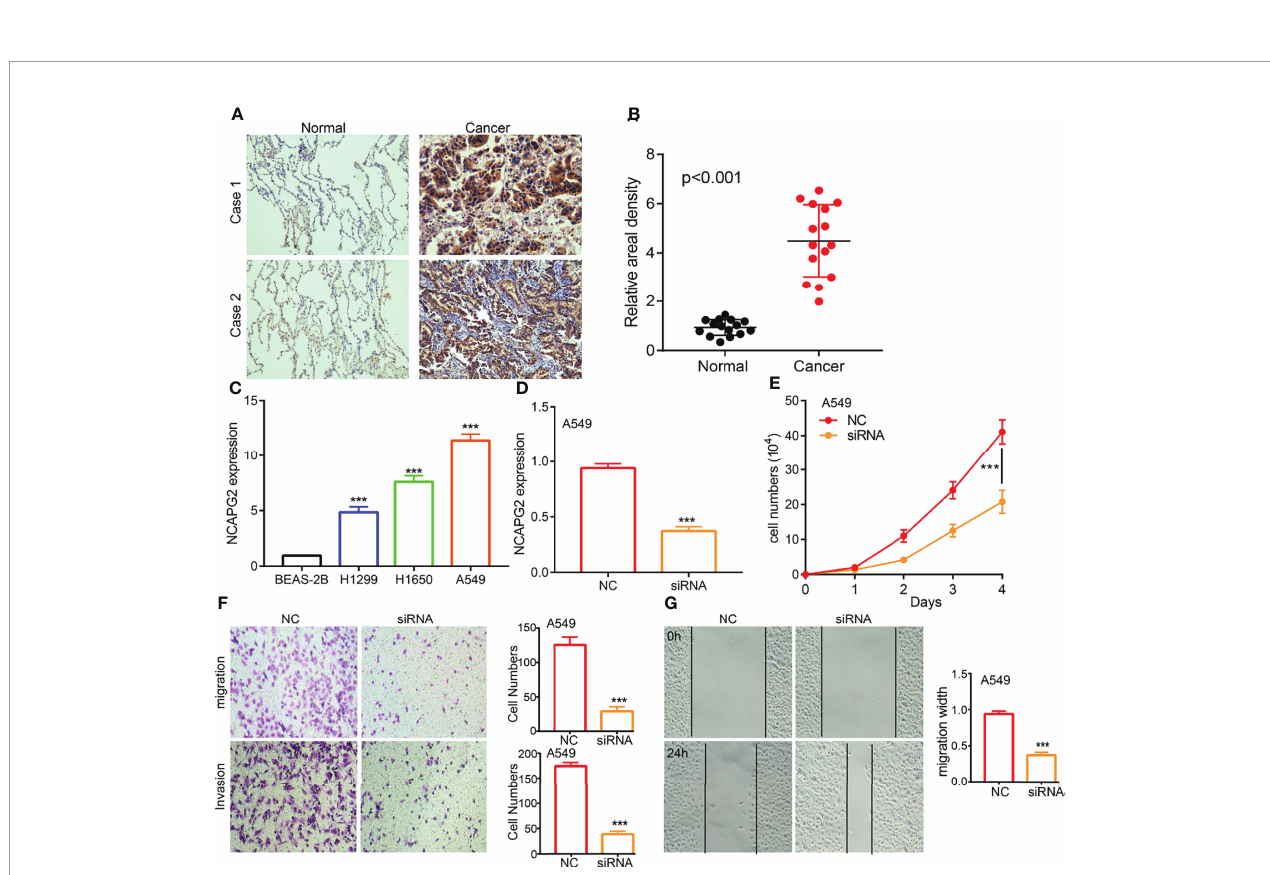
FIGURE 11 | NCAPG2 regulates LUAD cell proliferation, cell migration, and cell invasion. (A, B) IHC assay detects the protein of NCAPG2 in lung adenocarcinoma cancerous cell lines. (C) qPCR assay examines the expression level of NCAPG2 in lung adenocarcinoma cancerous cell lines, including A549, H1299, and H1650, compared to the normal human bronchial epithelial cell line: BEAS-2B. (D) Validation the knock down ef fi ciency of NCAPG2 in A549 cells by using qPCR assay. (E – G) Knockdown of NCAPG2 inhibited cell proliferation and migration examined by CCK8 and transwellassay.NC, negative control; siRNA, NCAPG2 siRNA; ***p <